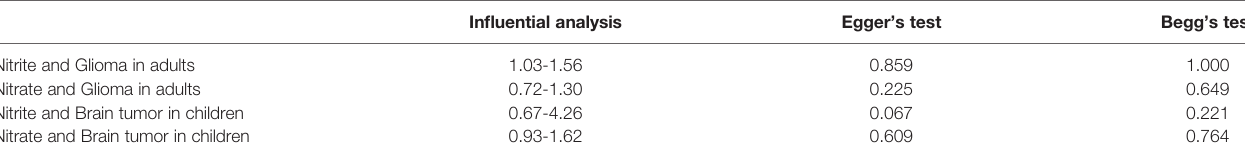
TABLE 4 | Sensitivity analysis and publication